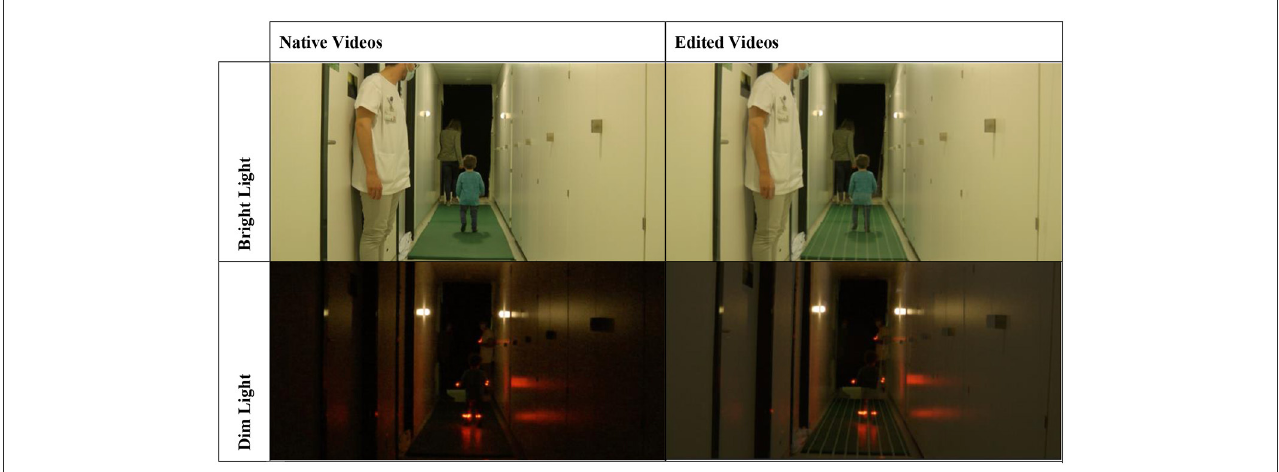
FIGURE2 Illustration of the two conditions of the test: bright light—BL (upper panels) and dim light—DL (lower panels) , before video editing (left panels) and after video editing (right panels) .